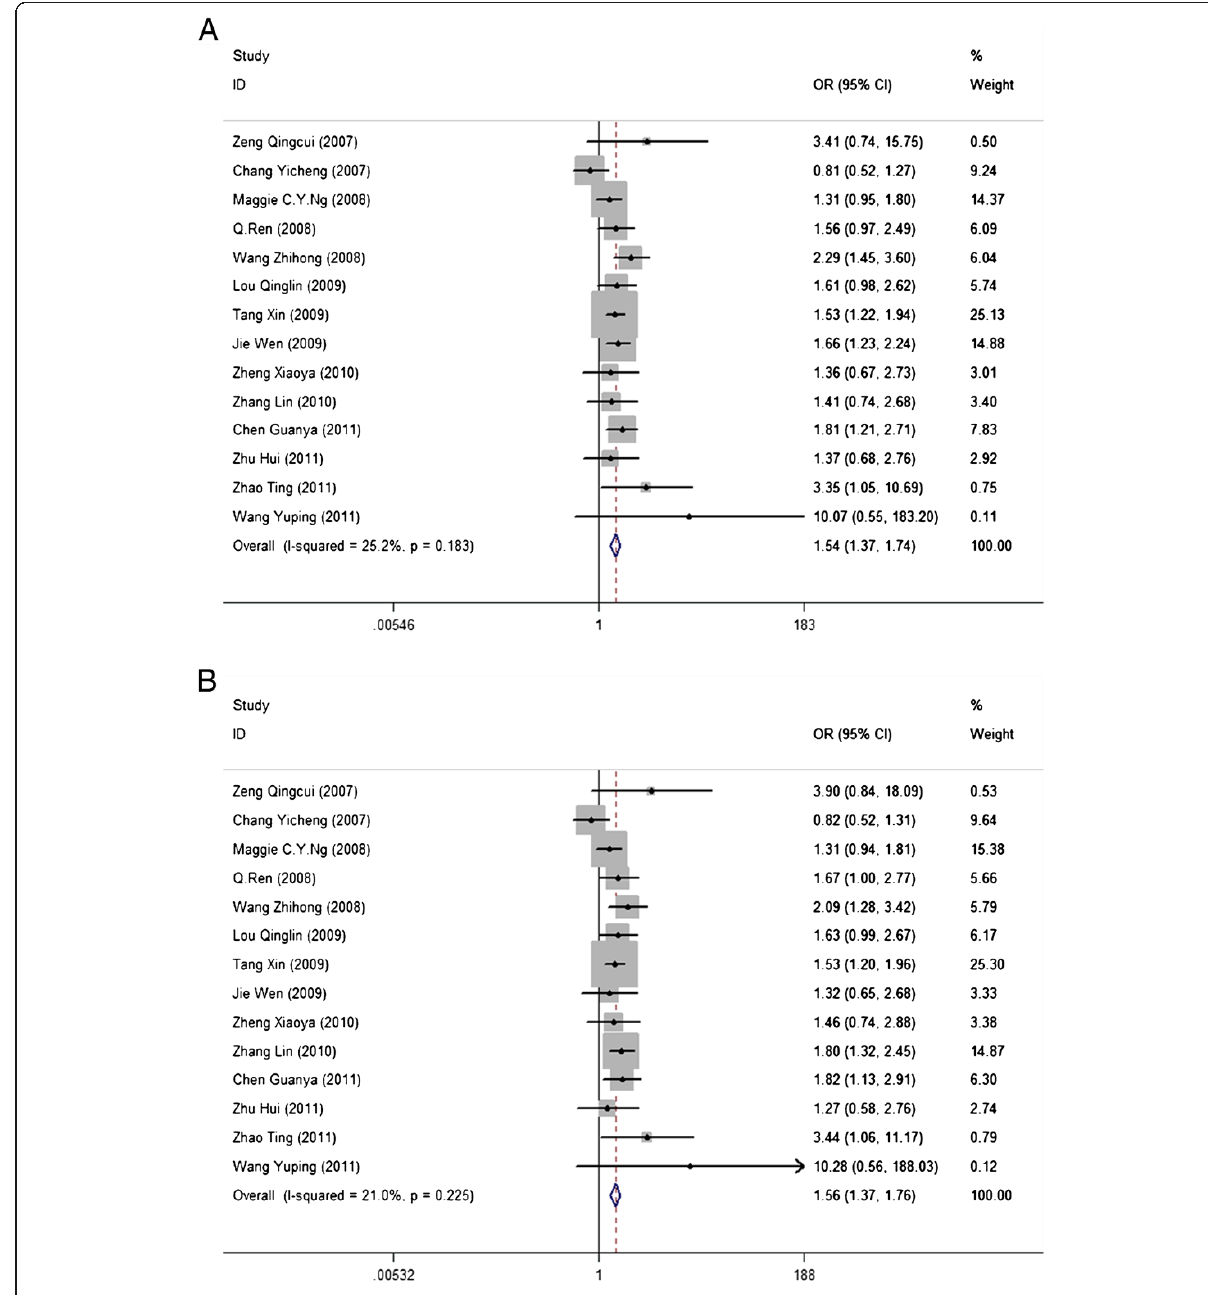
Figure 3 Forest plots for rs7903146. For the association between the T and C alleles of rs7903146 and risk of T2DM ( A , OR = 1.54, 95% CI: 1.37 – 1.74, p = 1.47 × 10 -12 , I 2 = 25.20%), and for the association between rs7903146 heterozygotes and C homozygotes and risk of T2DM ( B , OR = 1.56, 95% CI: 1.34 – 1.76, p = 8.25 × 10 -9 , I 2 =